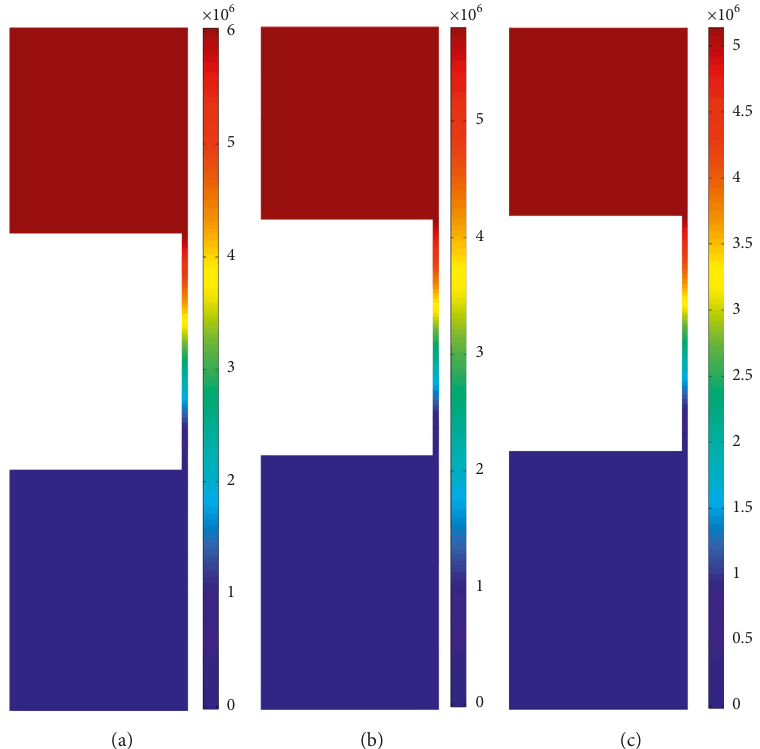
Figure 16: Pressure field (Pa) in the MR damper under sinusoidal displacement excitations of 1.27cm, 0.2Hz, 2 A: (a) t � T /12; (b) t � 2 T /12; (c) t � 3 T /12.